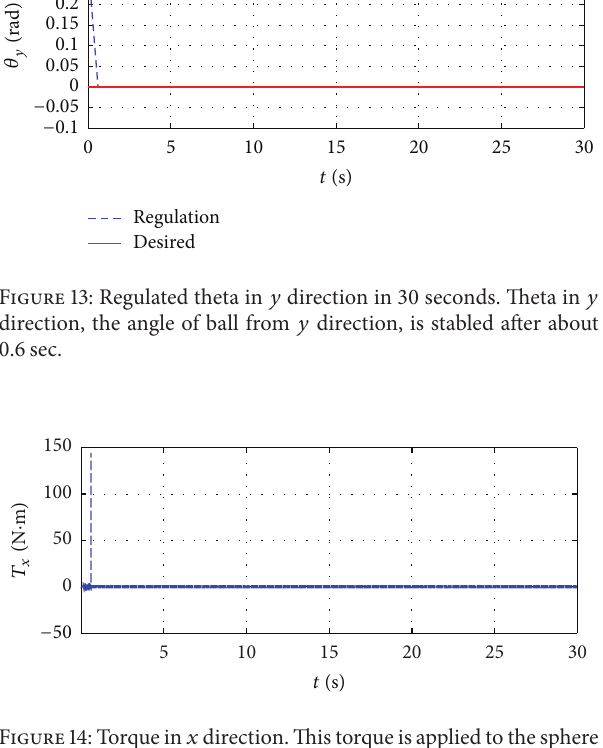
Figure 14: Torque in 𝑥 direction. This torque is applied to the sphere in the 𝑥 direction to control the position of the ball by means of changing beta in 𝑥 direction.